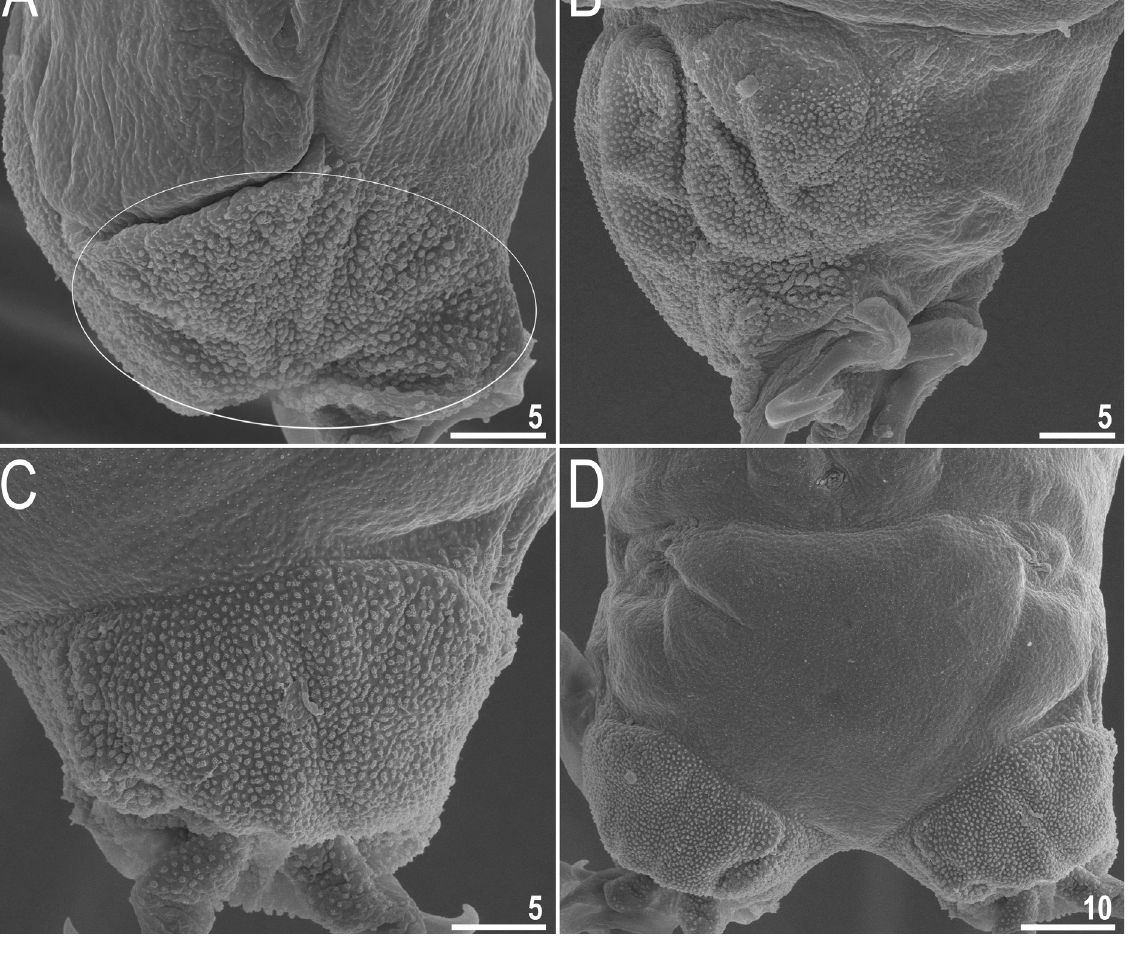
Fig. 13. Tenuibiotus zandrae sp. nov. Patches of dense granulation on legs seen in SEM (paratypes). A . External granulation on leg II (patch of dense granulation encircled). B . Internal granulation on leg III. C . Granulation on leg IV. D . Granulation on legs IV and uniformly distributed body granulation on the dorso-caudal region. Scale bars in